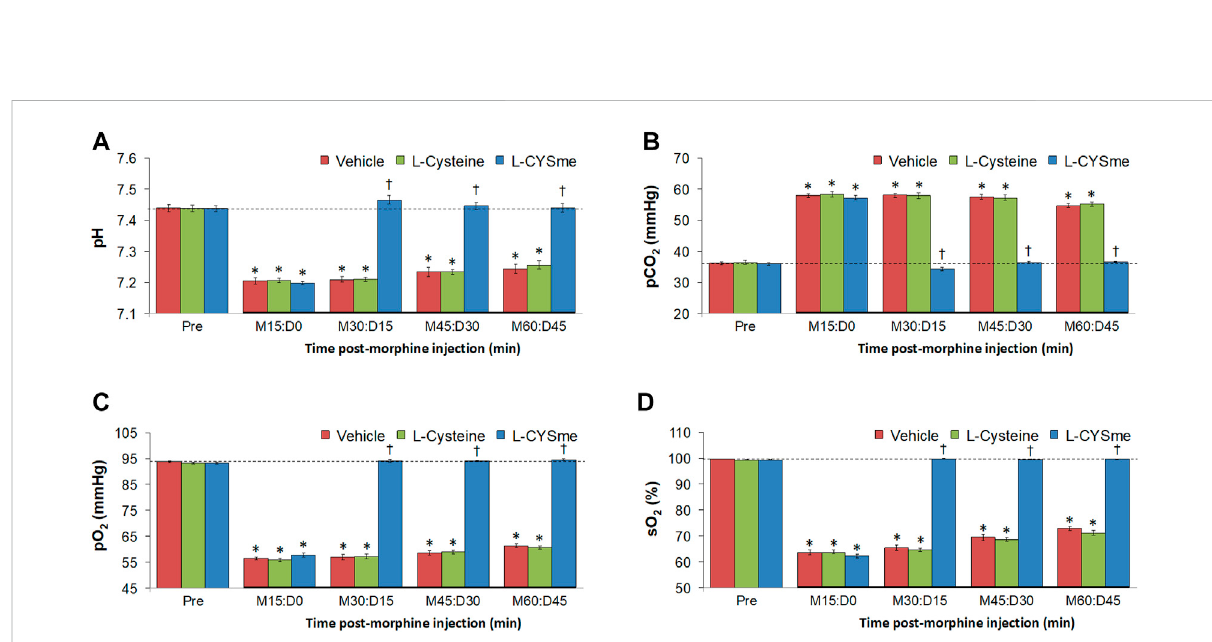
FIGURE 10 Values of pH Panel (A) , pCO 2 Panel (B) , pO 2 Panel (C) and sO 2 Panel (D) before (Pre) and after injection of morphine (10 mg/kg, IV) in three separate groups of freely-moving rats followed by injection of vehicle (VEH, saline), L-cysteine (500 μ mol/kg, IV) or L-cysteine methyl ester (L-CYSme, 500 μ mol/kg, IV). The terms M15, M30, M30, M45 and M60denote 15,30, 45and 60 min after injection of morphine. The terms D0, D15, D30andD45denote0,15,30and45 minafterinjectionofdrug(vehicle,L-CysteineorL-CYSme).Thedataareprsentedasmean±SEM.There were 9 rats in each group. * p < 0.05, signi fi cant change from Pre values. † p < 0.05, signi fi cant change between L-CYSme versus